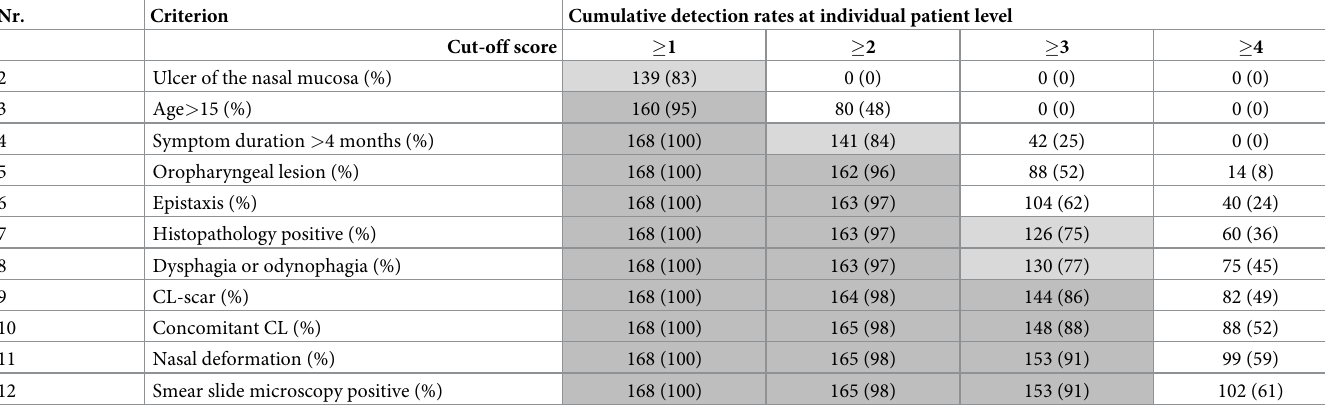
Table 5. Cumulative detection rates of clinical criteria in 168 male Mucosal Leishmaniasis (ML) patients. Nr.